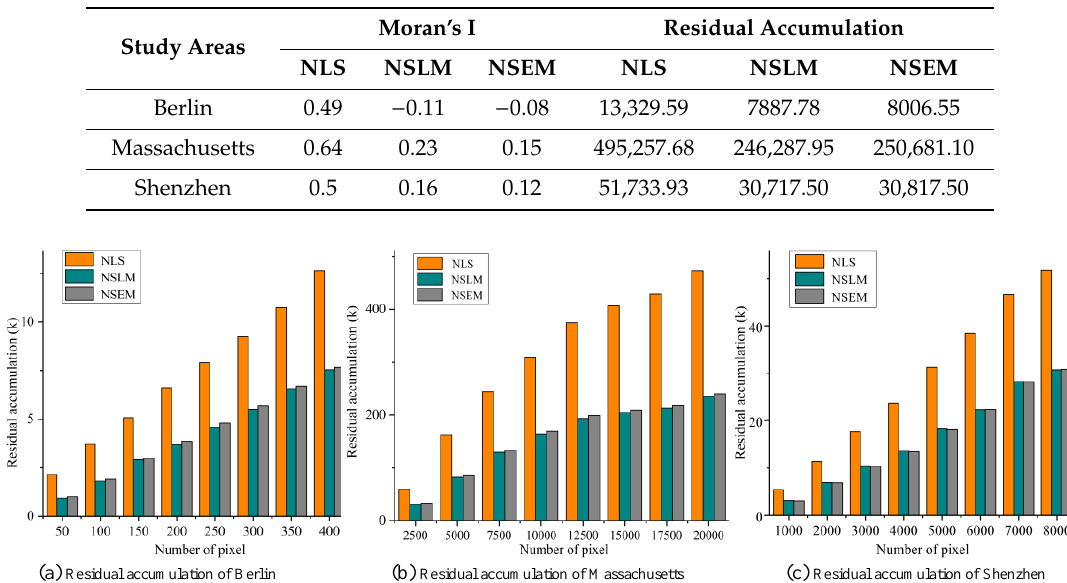
Table 3. Moran’s I values of regression residuals and residual accumulations in three study areas. Study Areas